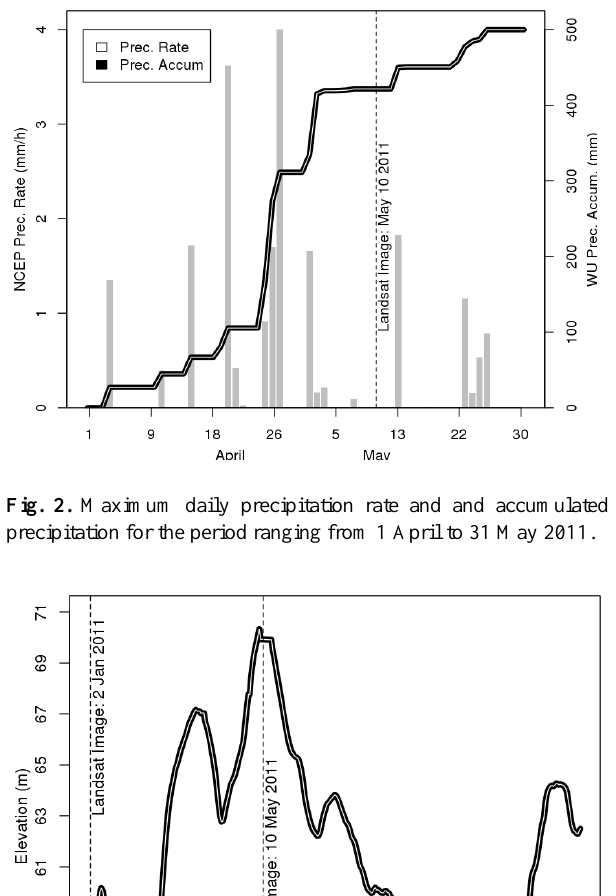
for each pixel to be flooded.